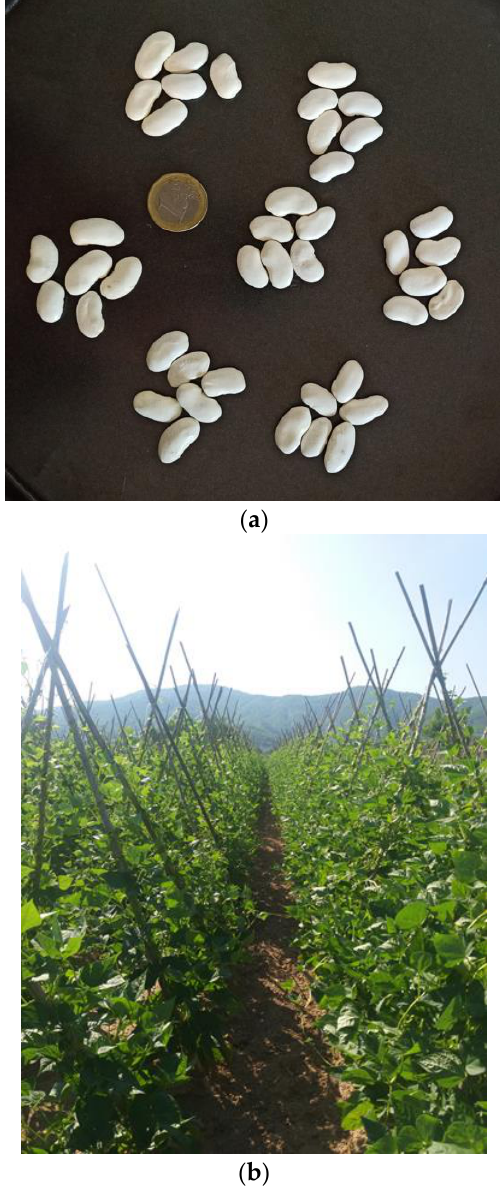
Figure 1. ( a ): White beans. ( b ): Phaseolus vulgaris. Table 1. Collection place, growth habit, seed shape, coat veining, and brilliance of the seven dry bean landraces .